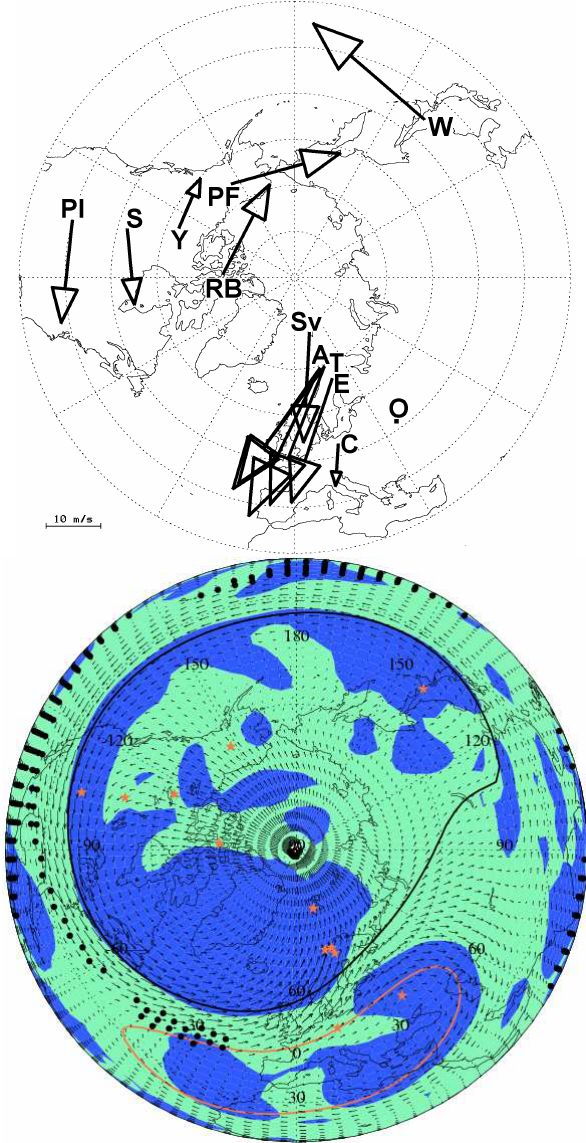
Fig. 8c. The same as Fig. 8a, but for 13 February 2005.